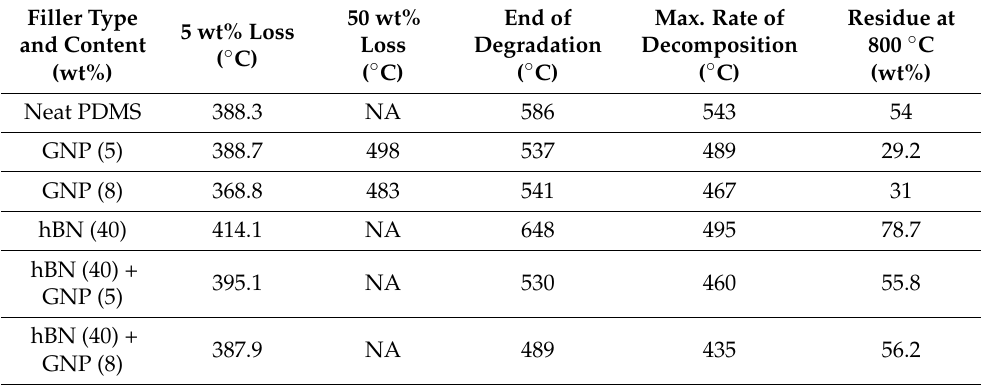
Figure 6. TGA curves for samples heated at 10 °C/min to 850 °C. Table 4. Results of TGA tests run at 10 ◦ C/min heating rate on neat PDMS samples and PDMS-based samples containing different amounts of hBN and